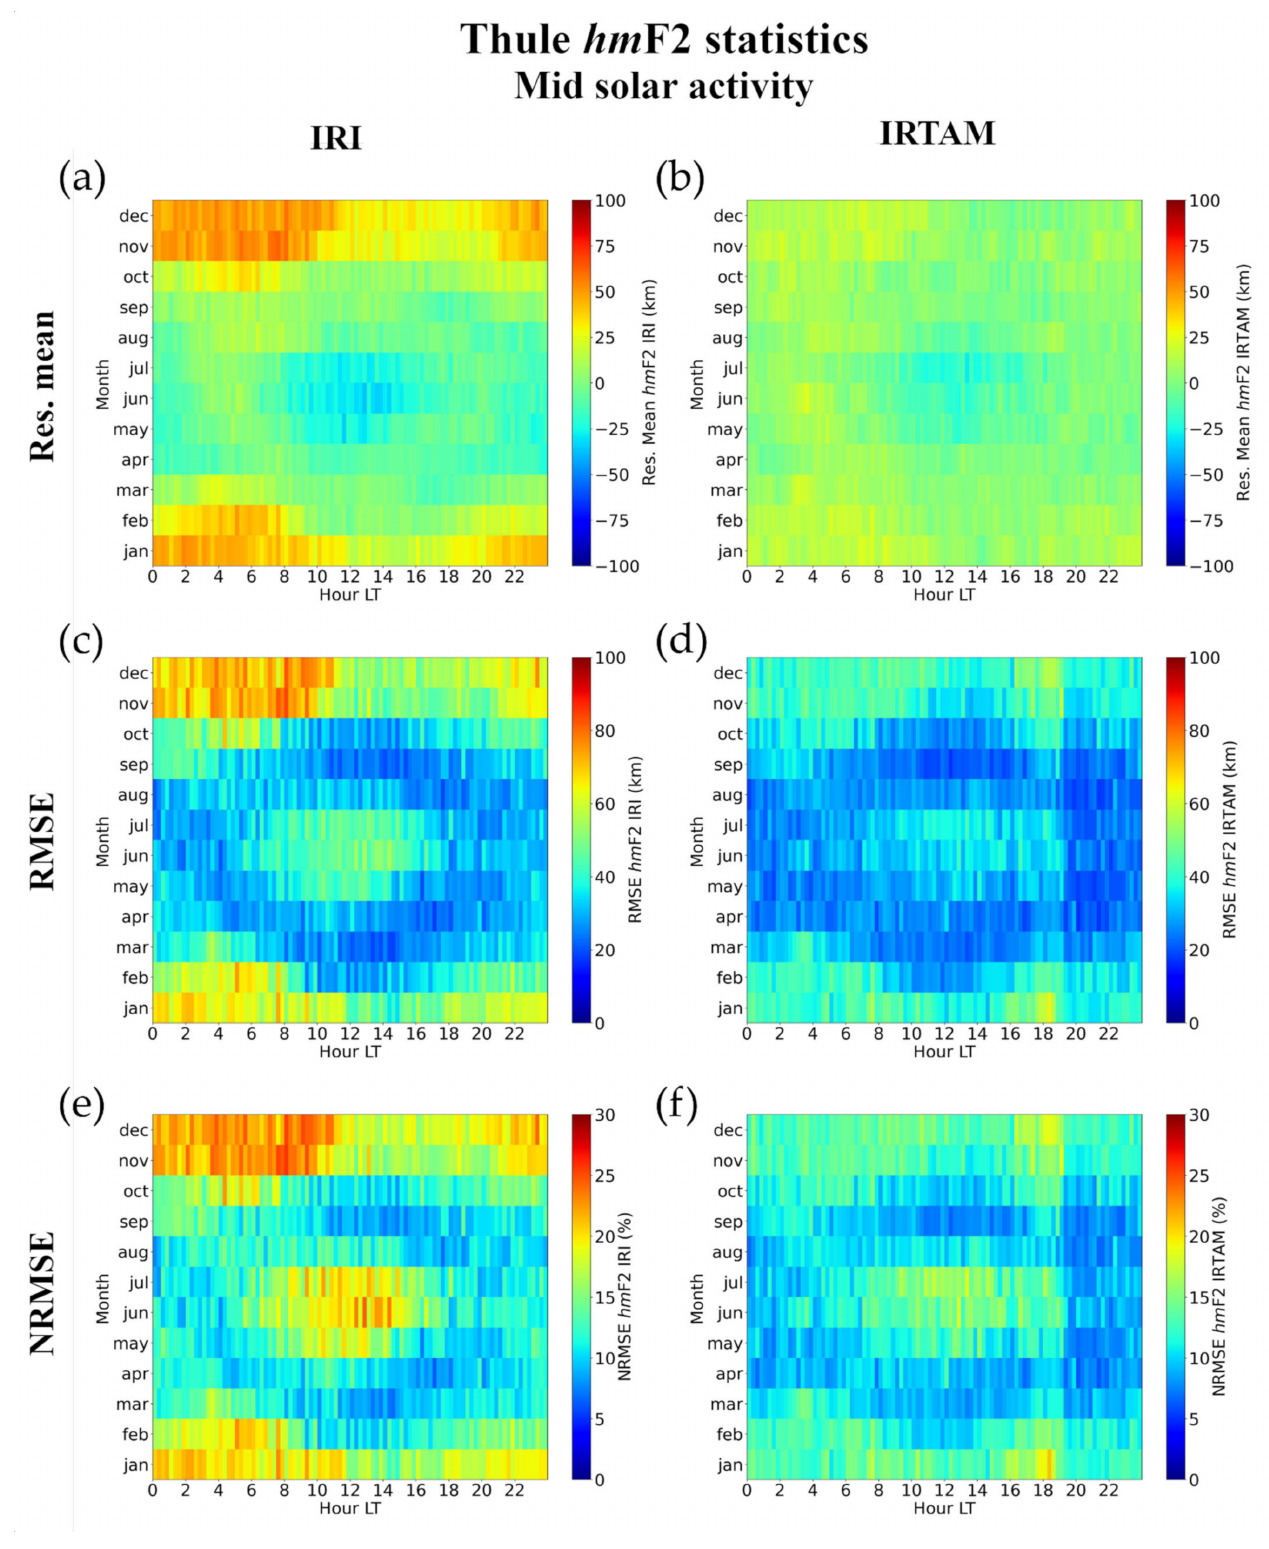
Figure 38. Same as Figure 37 but for MSA